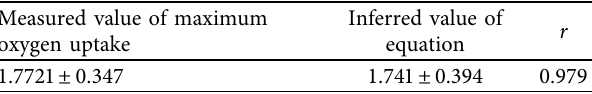
Figure 2: Scatter diagram between inferred maximum oxygen uptake and measured maximum oxygen uptake. Table 5: Comparison of difference between measured value and inferred value.